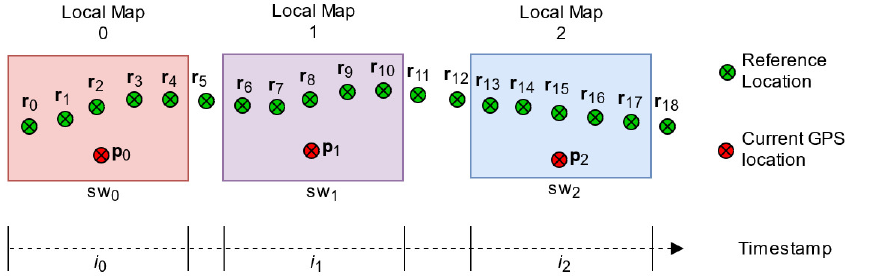
Figure 3. Illustration of Map-matching process using sliding window ( sw i